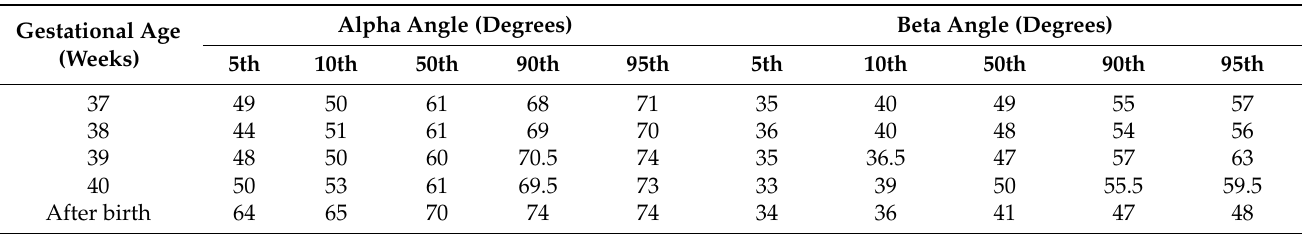
Figure 5. Beta-angle percentile curves for gestational age 37 to 40 weeks (37 weeks: n = 131; 38 weeks: n = 101; 39 weeks: n = 100; 40 weeks: n = 100). Table 2. Values of alpha-angle and beta-angle percentiles for gestational age 37 to 40 weeks (37 weeks: n = 131; 38 weeks: n = 101; 39 weeks: n =100; 40 weeks: n = 100). Post-natal percentiles are also presented ( n = 324).